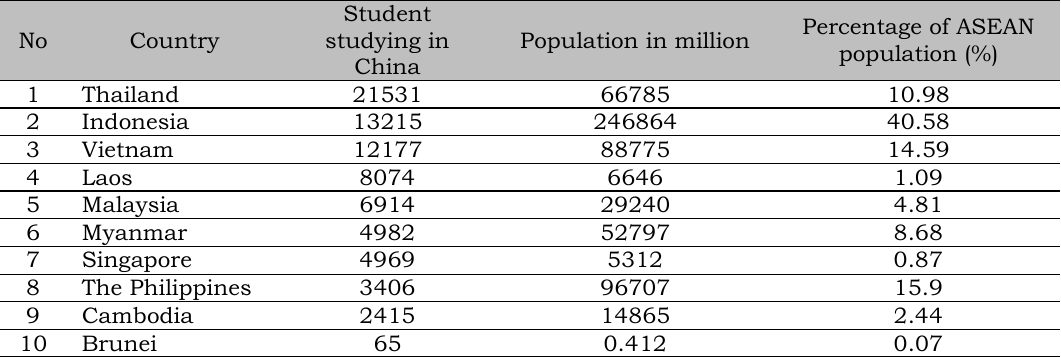
Table 4. Students from ASEAN Countries in comparison to ASEAN country population